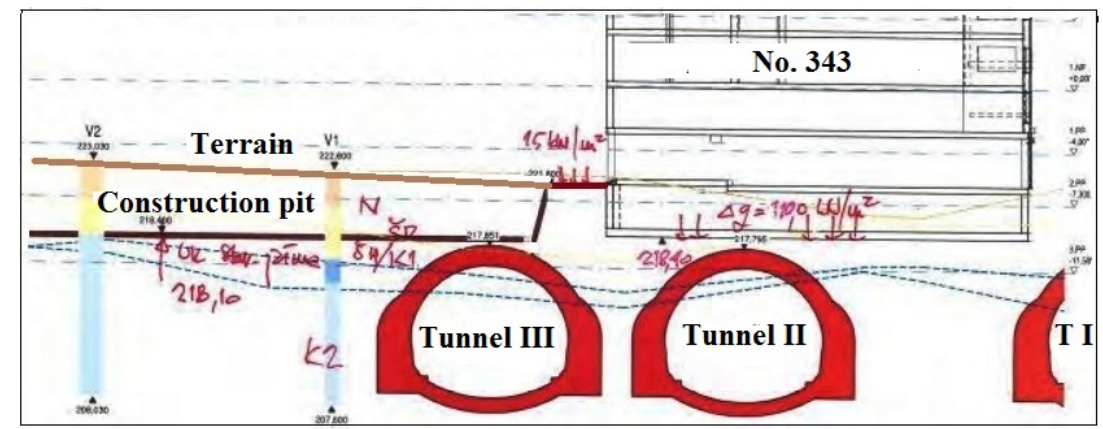
Figure 8. Construction phase 500 Demolition and Construction pit in section III’ [2].